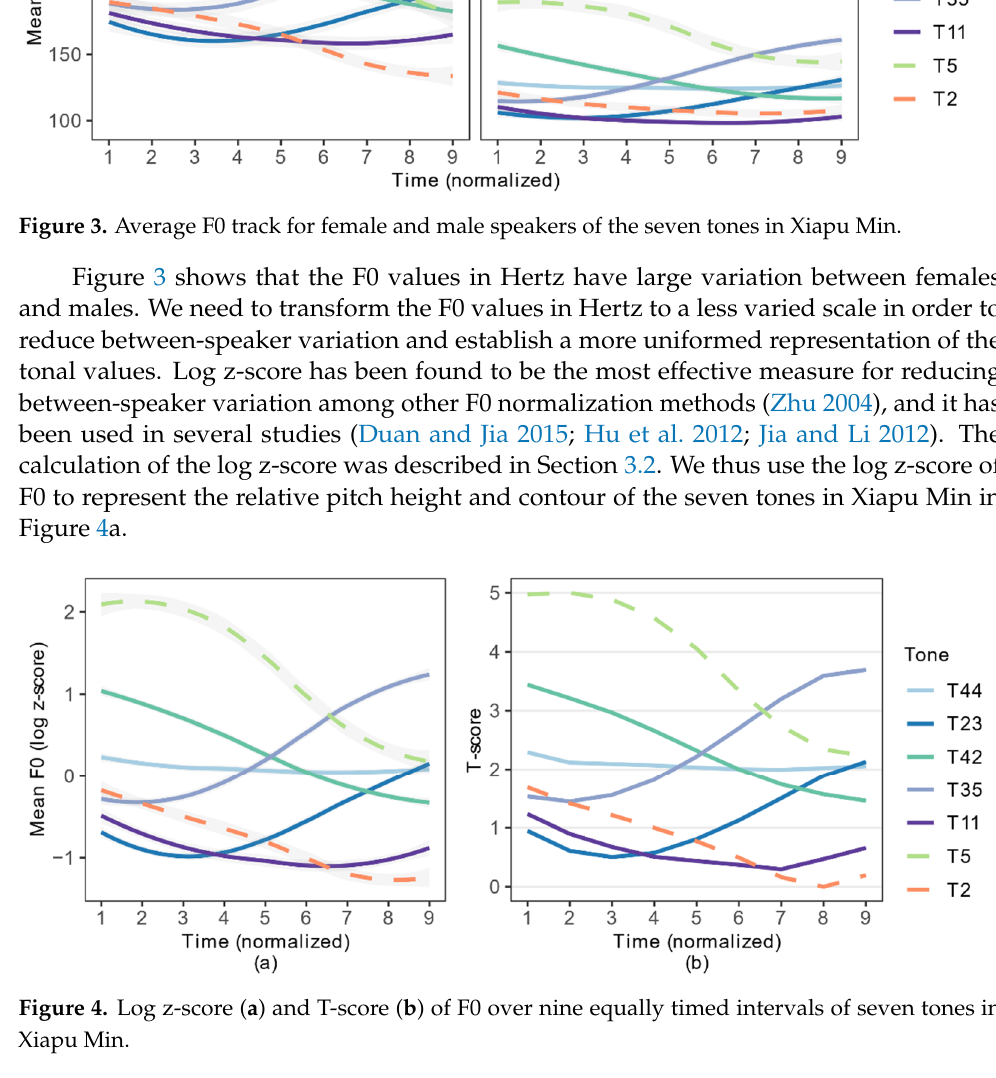
Figure 4. Log z-score ( a ) and T-score ( b ) of F0 over nine equally timed intervals of seven tones in Xiapu Min.